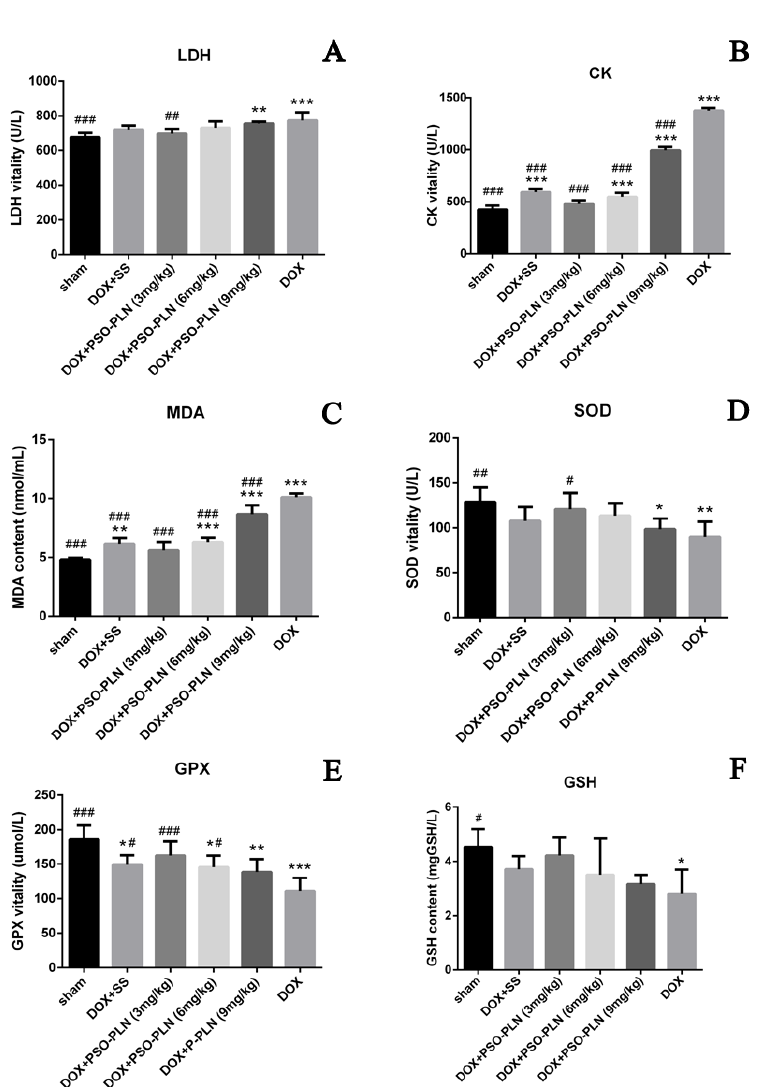
FIGURE 6 - Effect of PSO-PLN on serum levels of lactate dehydrogenase (LDH), creatine kinase (CK), malondialdehyde (MDA), superoxide dismutase (SOD), glutathione (GSH) and glutathione peroxidase (GPX) in DOX-treated